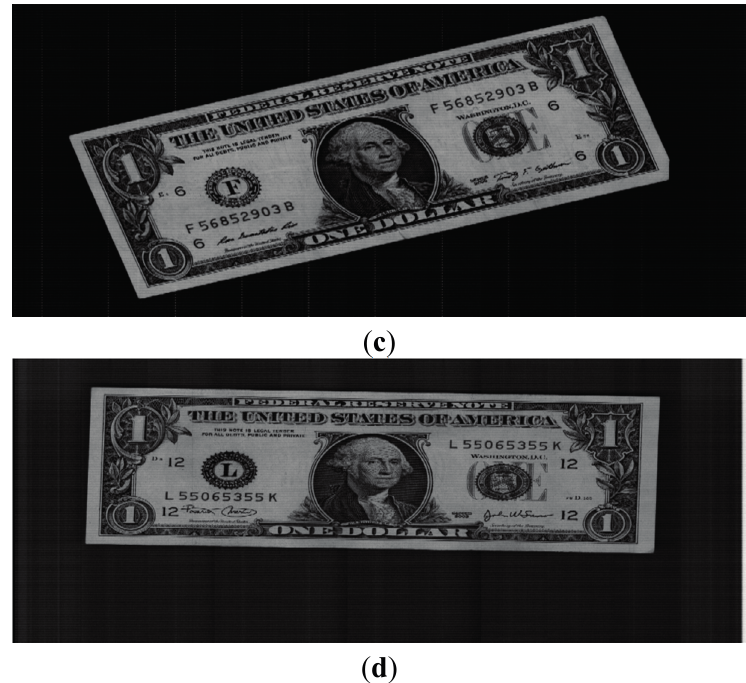
Figure 2. Examples of misalignment, geometric distortion, and non-uniform illumination on the captured images: the cases of ( a ); ( b ) misalignment; ( c ) geometric distortion; and ( d ) non-uniform